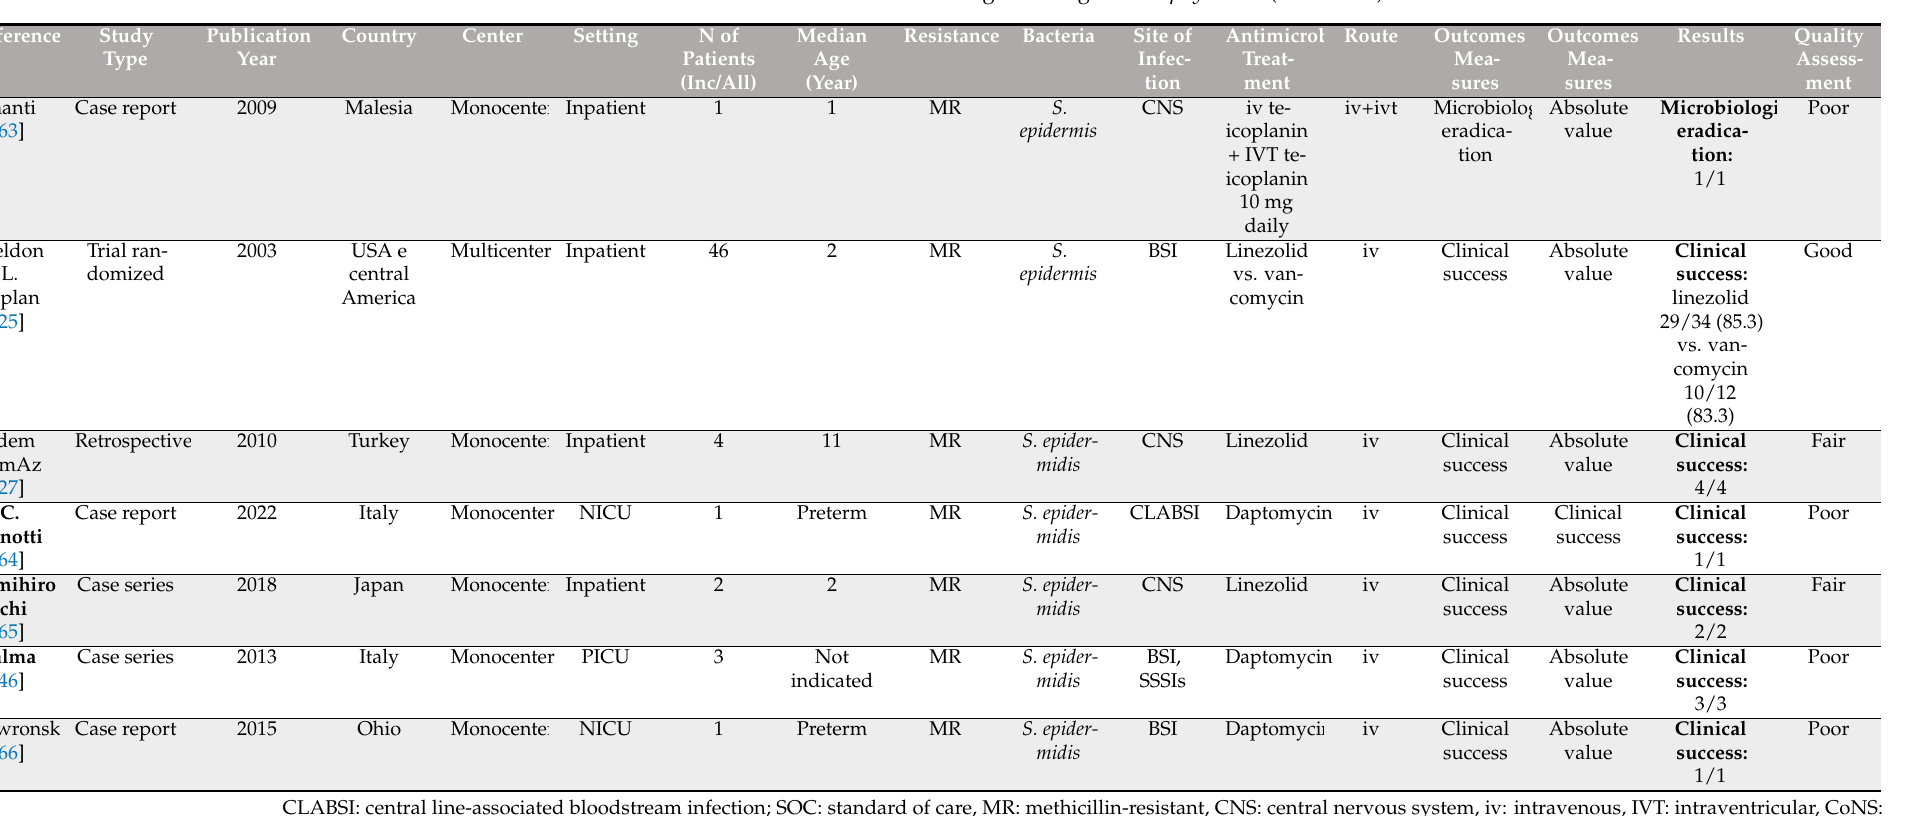
Table 3. Choice of treatment and outcomes for methicillin-resistant coagulase-negative staphylococci